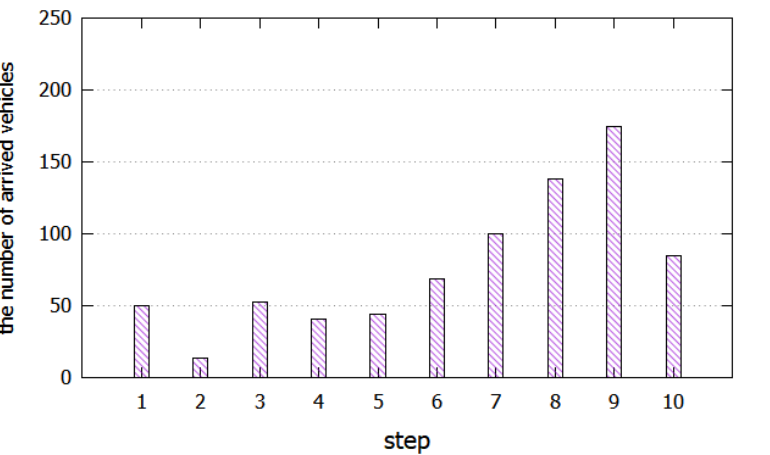
Figure 9. Traffic distribution used in the experiment.